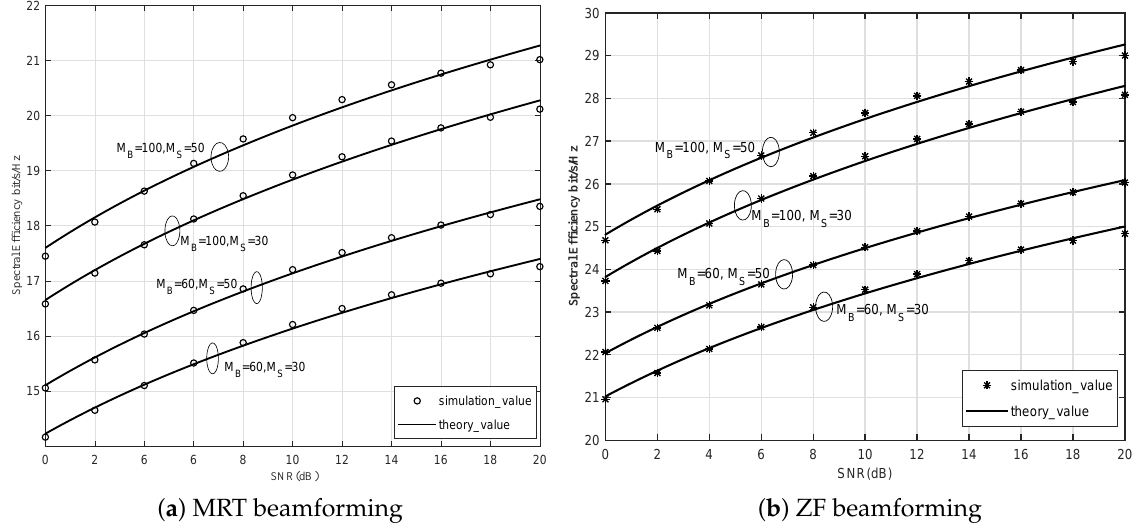
Figure 3. SE against SNR with MRT and ZF